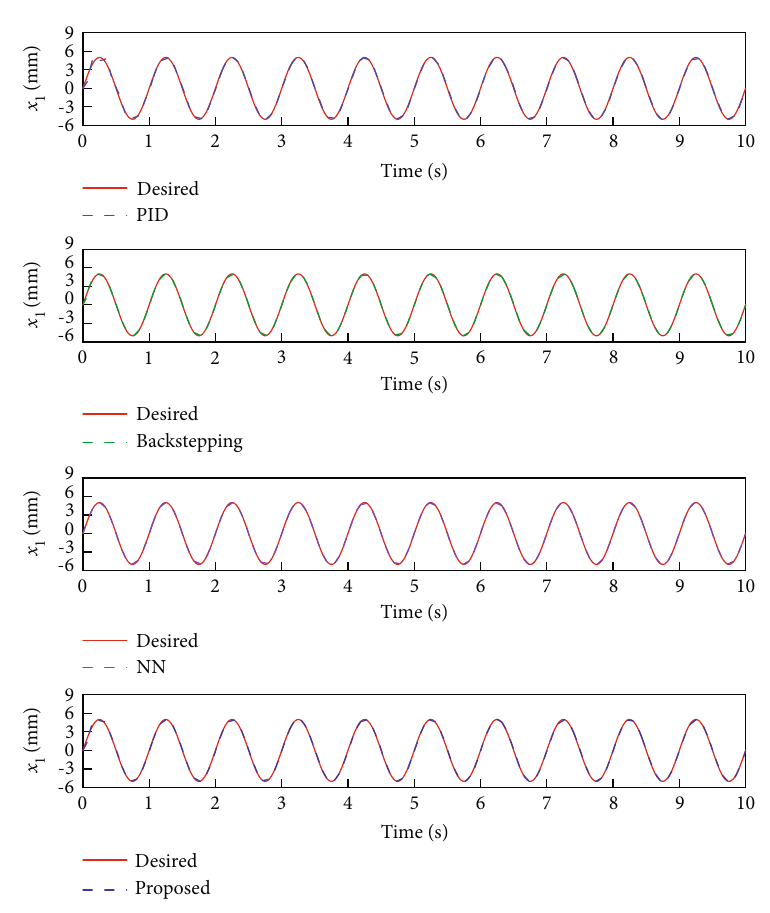
Figure 8: Tracking performance of sine